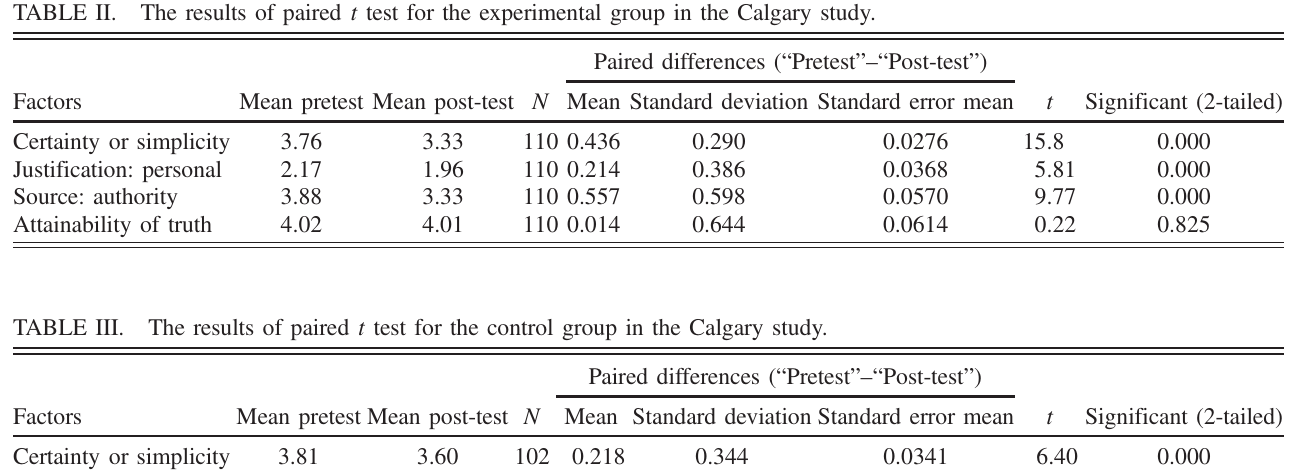
Paired differences ( “ Pretest ” – “ Post-test ” )